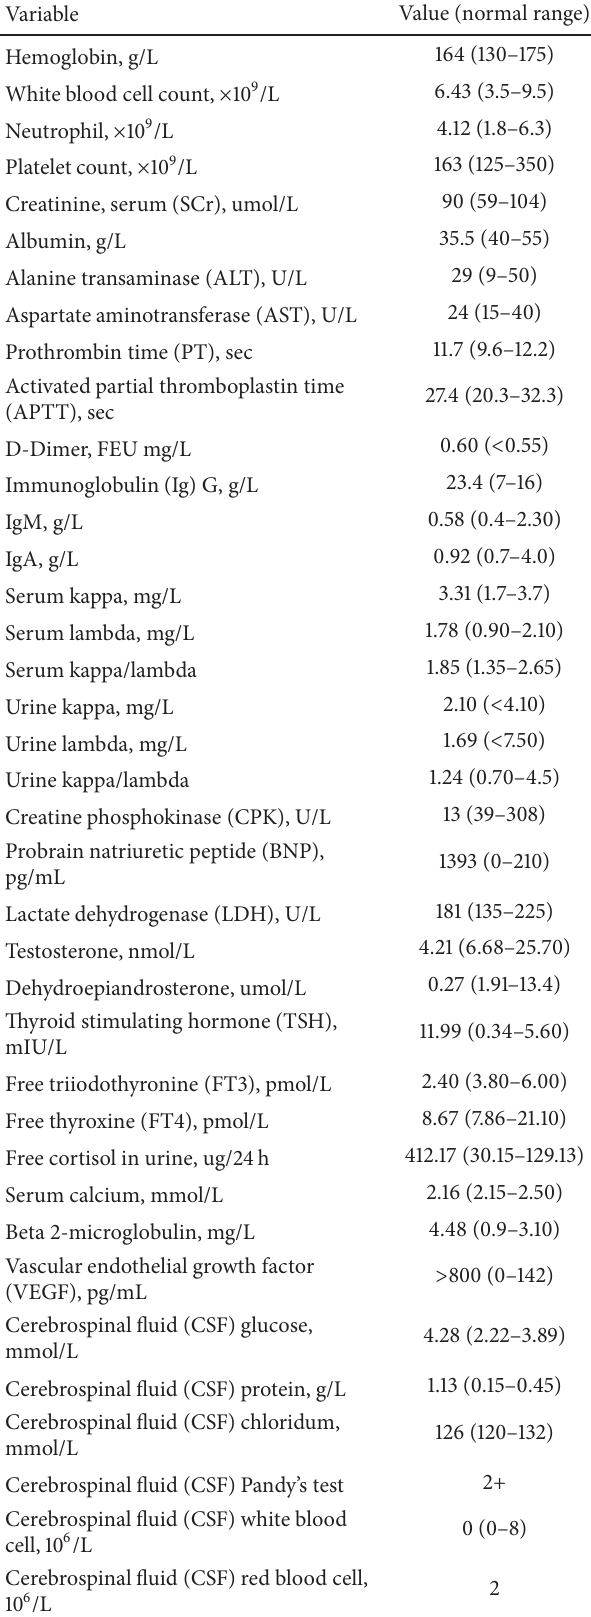
Table 1: Laboratory